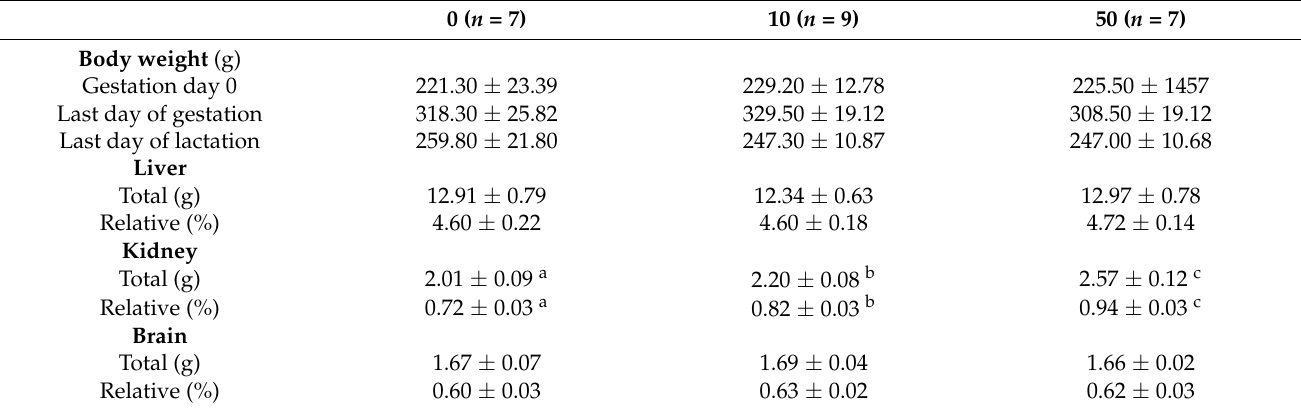
Table 2. Body weight, total and relative weight organs weight of dams exposed to different doses